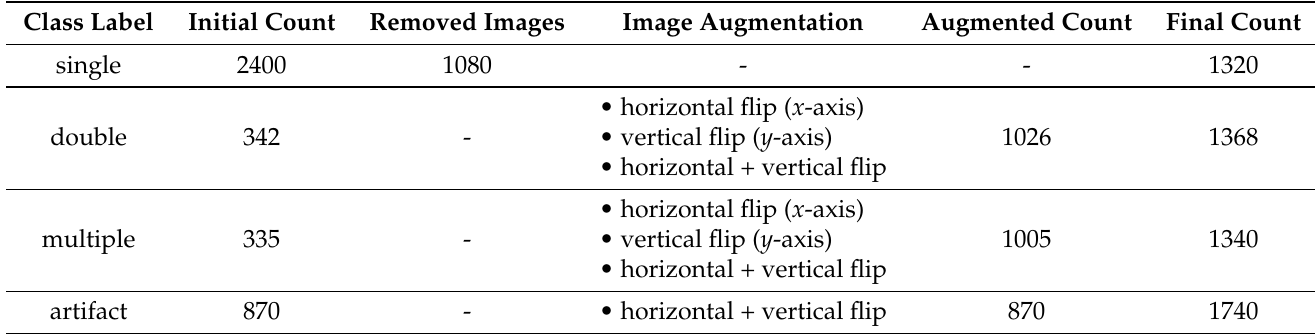
Table 1. Image patches augmentation techniques for class